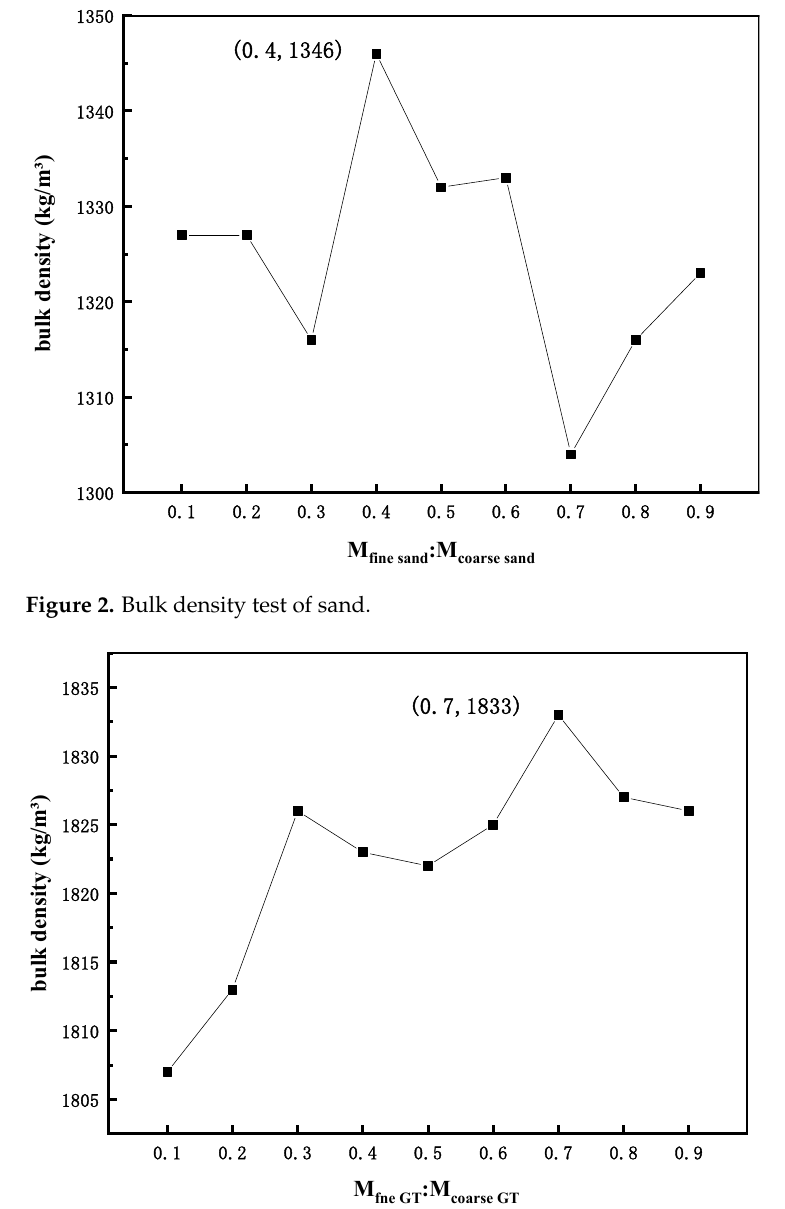
Figure 3. Bulk density test of GT.